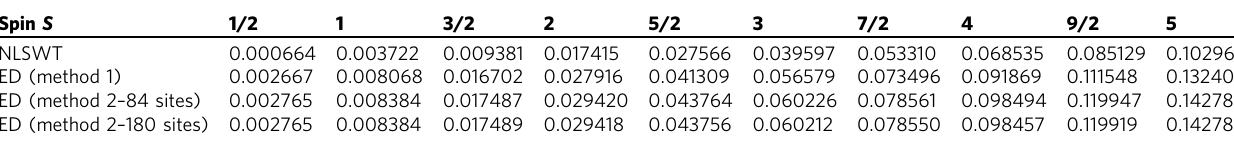
Table 1 Numerical values of J m / K extracted from the non-linear spin-wave theory ( fi rst row), and exact diagonalizations (last three